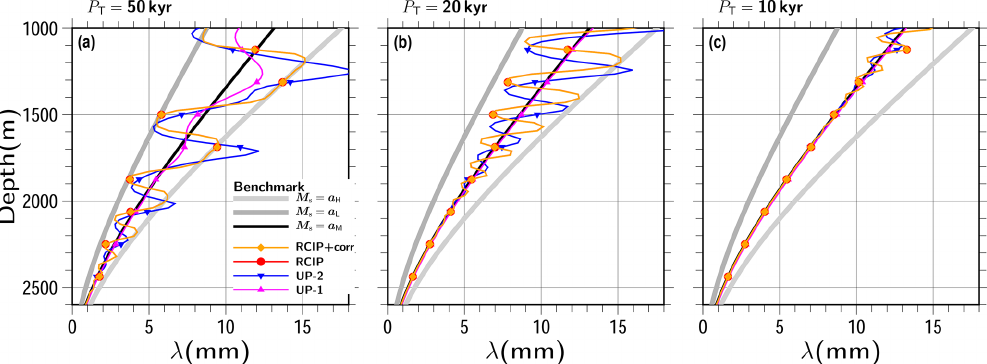
Figure 15. Results of transient experiments conducted with the square-wave surface mass balances of a H ,a L = 3 and 1.5cmyr − 1 and P H : P L = 1 : 1 (Eq. 57), and the total duration as (a) P T = 50kyr, (b) P T = 20kyr, and (c) P T = 10kyr. The basal mass balance is set as 0 for all the experiments in the figure. The vertical profiles of the annual layer thickness λ at 1000kyr using RCIP+corr , RCIP (which overlaps with RCIP+corr ), UP-2 , and UP-1 are shown. The gray and black lines indicate benchmark solutions of constant surface mass balance cases with a H , a L , and a M = (a H + a L )/ 2 given as references. Uniform grid spacing of 129 levels is adopted in this simulation. The results covering the depth from 1000 to 2600m are